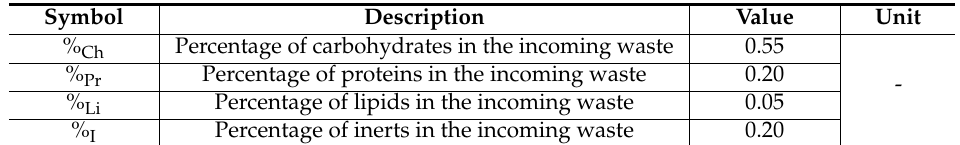
Table 5. Incoming waste